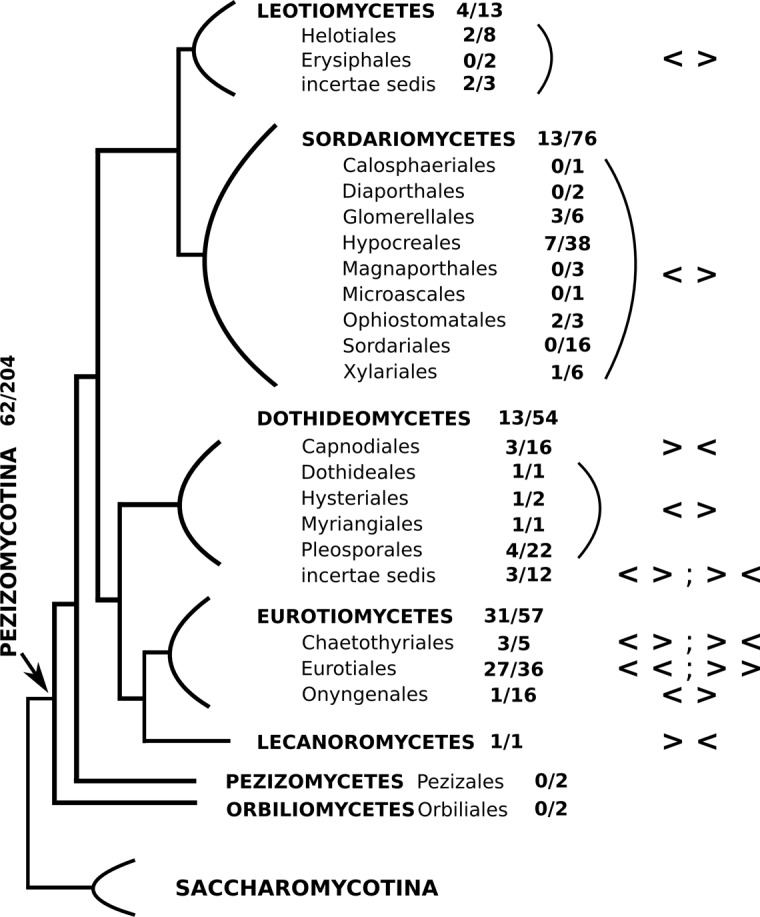
Schematic representation of selective conservation of the CYP630-CPR2 gene cluster in Pezizomycotina.The presence of the gene cluster found in seven Pezizomycotina classes is given as a fraction of the species that the gene cluster was identified in relative to all the species of a given class whose genomes were searched. Homologs of either gene were not identified outside of Pezizomycotina. The relative orientation of both genes is given (< >—divergent; > <—convergent, << or >>—co-oriented) [47]. The phylogeny was modeled after [48].